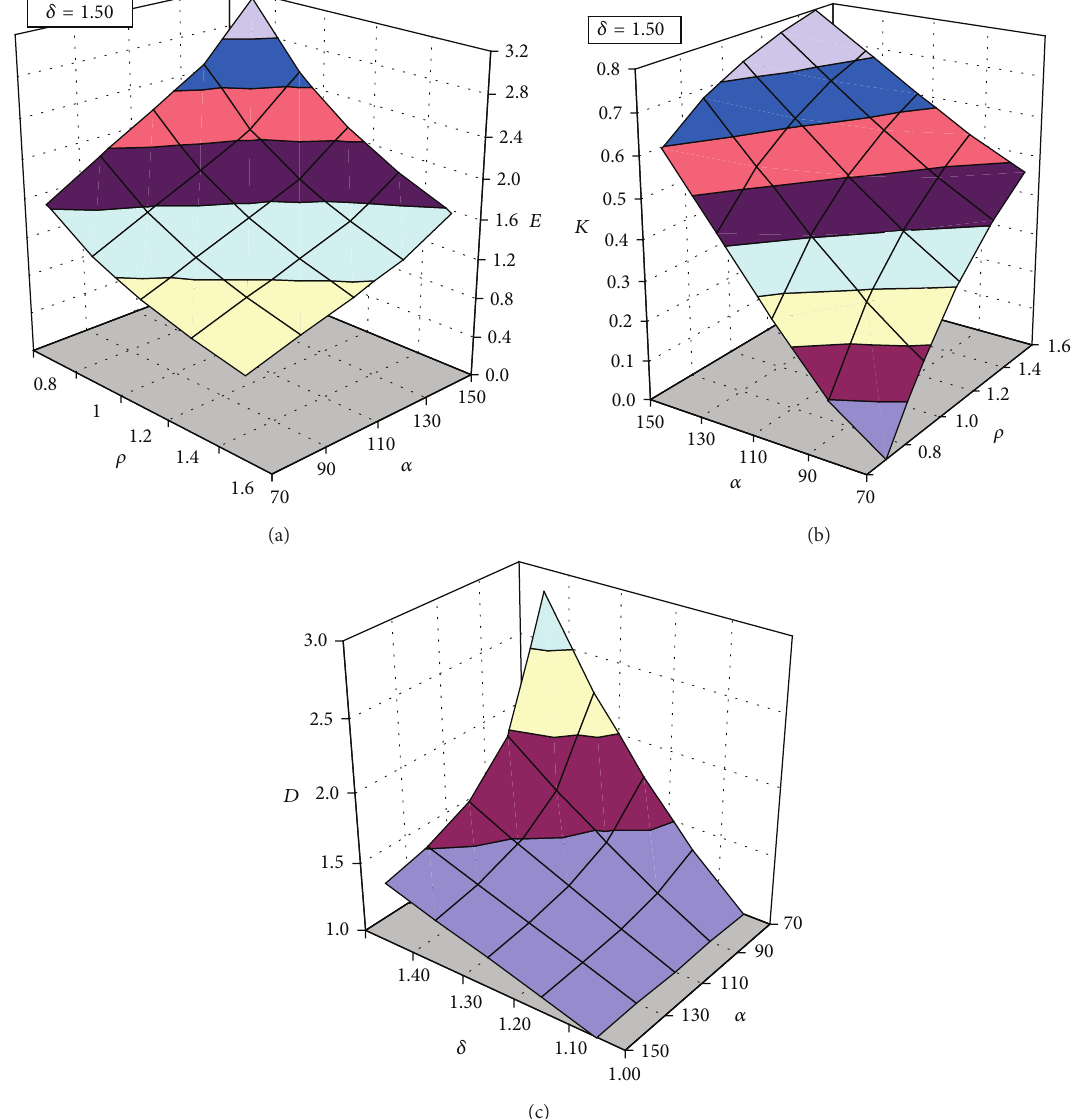
Figure 2: The elongation 𝐸 , the ventral convexity 𝐾 , and the dissymmetry 𝐷 of shell outline computed against growth-based parameters ((1), (2), and (3)). Ventral convexity 𝐾 is increasing with both 𝛼 and 𝜌 , while the elongation 𝐸 increases with 𝛼 but decreases with 𝜌 . The dissymmetry 𝐷 increases with 𝛿 and decreases with 𝛼